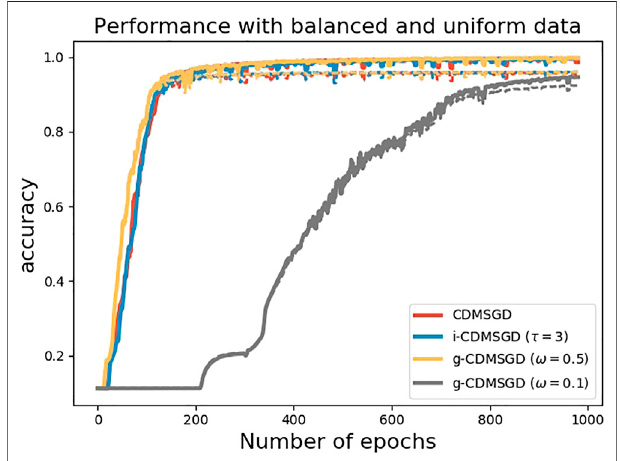
FIGURE 7 | Performance of different algorithms with a balanced data distribution on MNIST